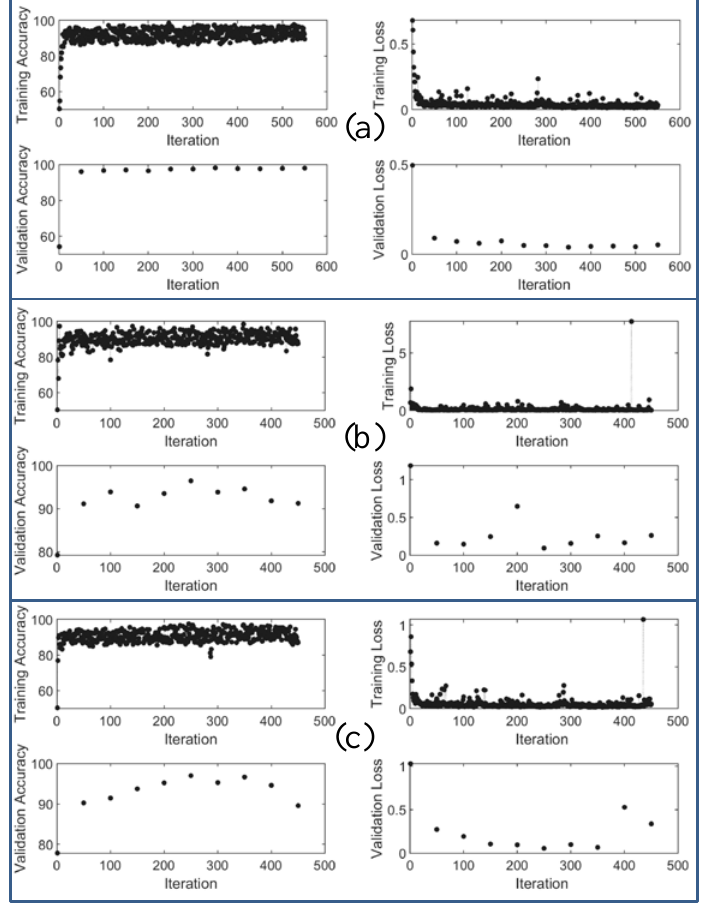
Figure 14. Training process of the DeepLab_v3+ using different gradient descent algorithms. ( a ) sgdm, ( b ) rmsprop, and ( c ) adam. Table 6. Detection results of the DeepLab_v3+ using different learning